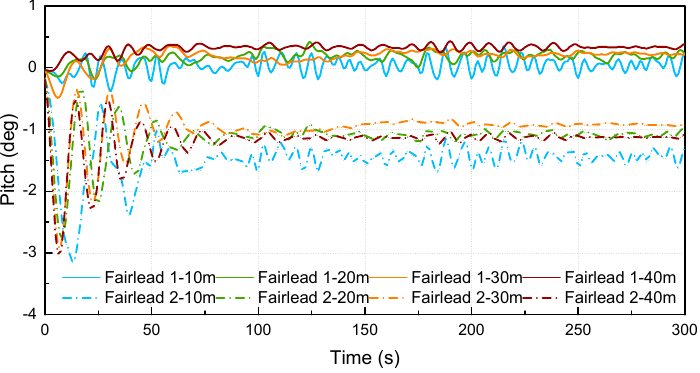
Figure 12. Pitch motion versus fairlead positions under different submerged depths.